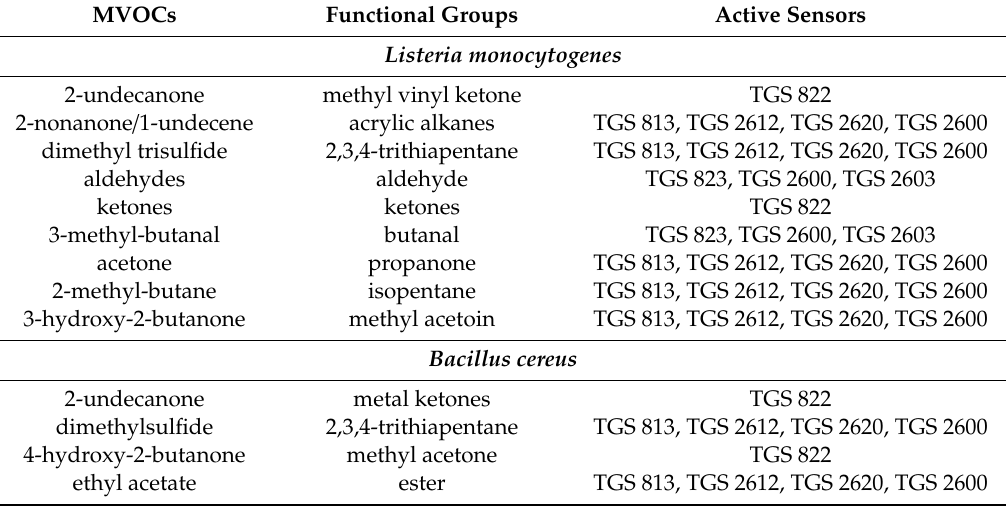
Table 3. Metabolic volatile organic compounds (MVOCs) and possible active